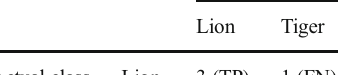
Table 2 Example confusion